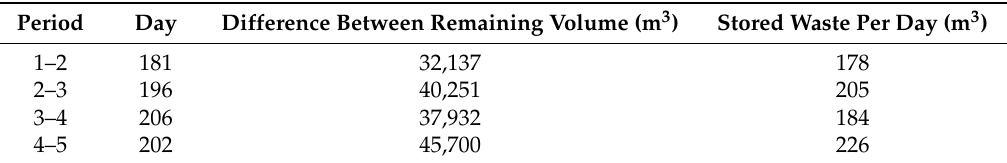
Table 3. Differences between remaining volume